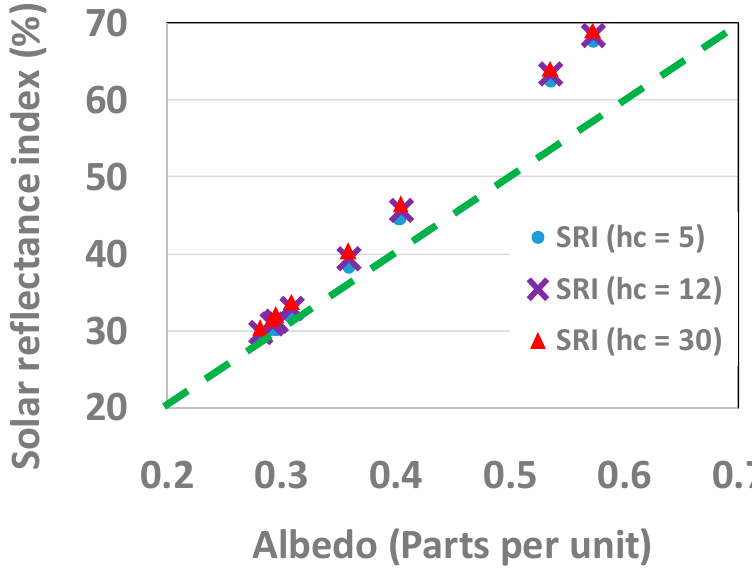
Figure 4. Correlation between the solar reflectance index (SRI) and albedo.